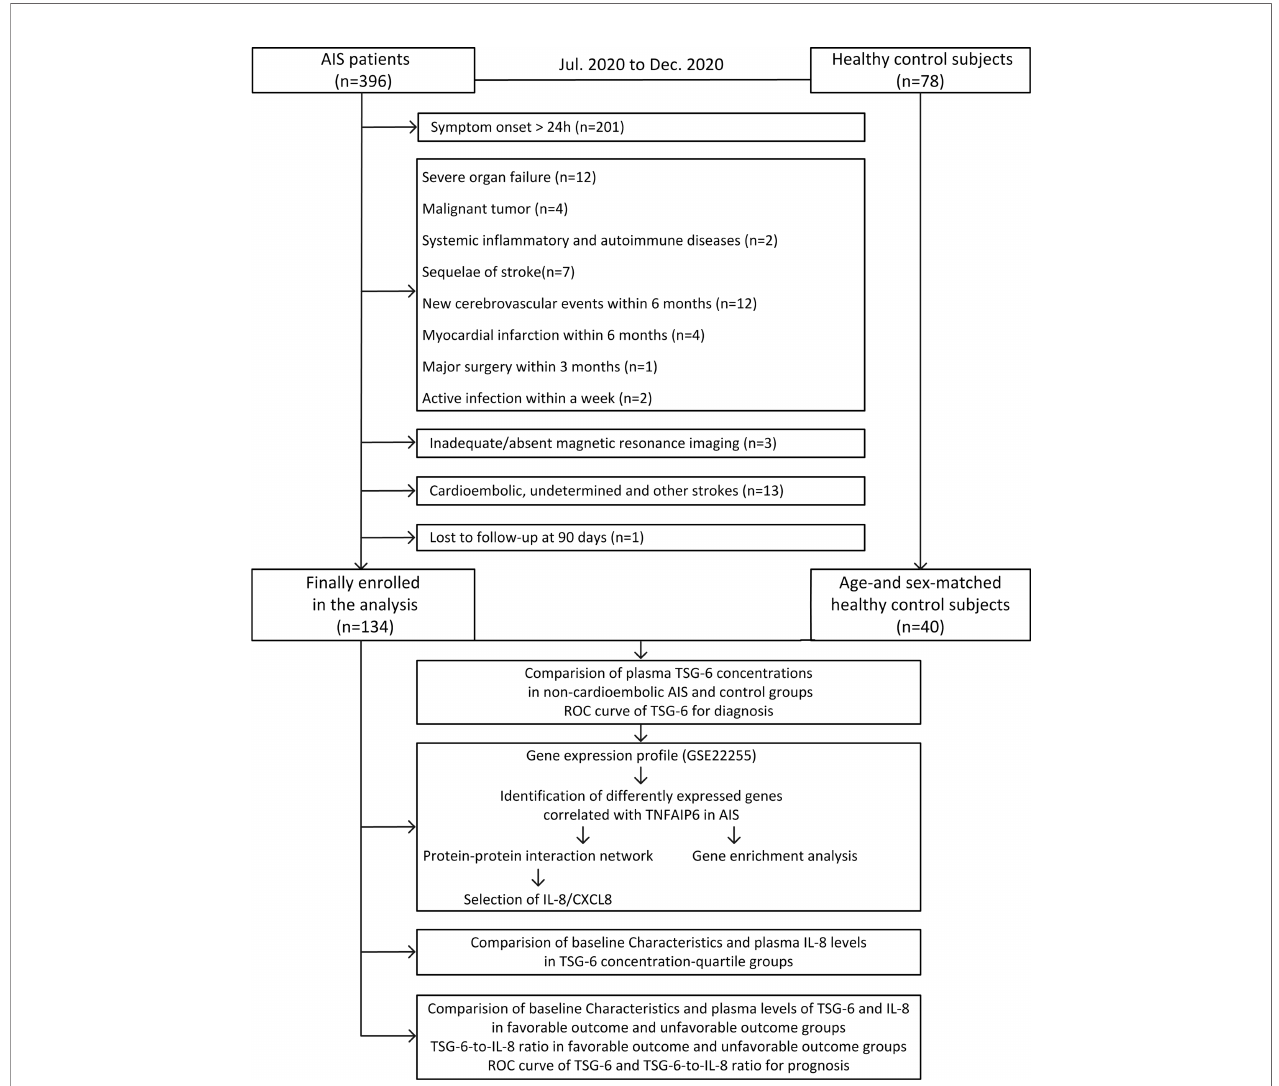
FIGURE 1 | Study fl owchart. AIS, acute ischemic stroke; TSG-6, tumor necrosis factor-stimulated gene-6; Roc,receiver-operating characteristic curve; IL-8,